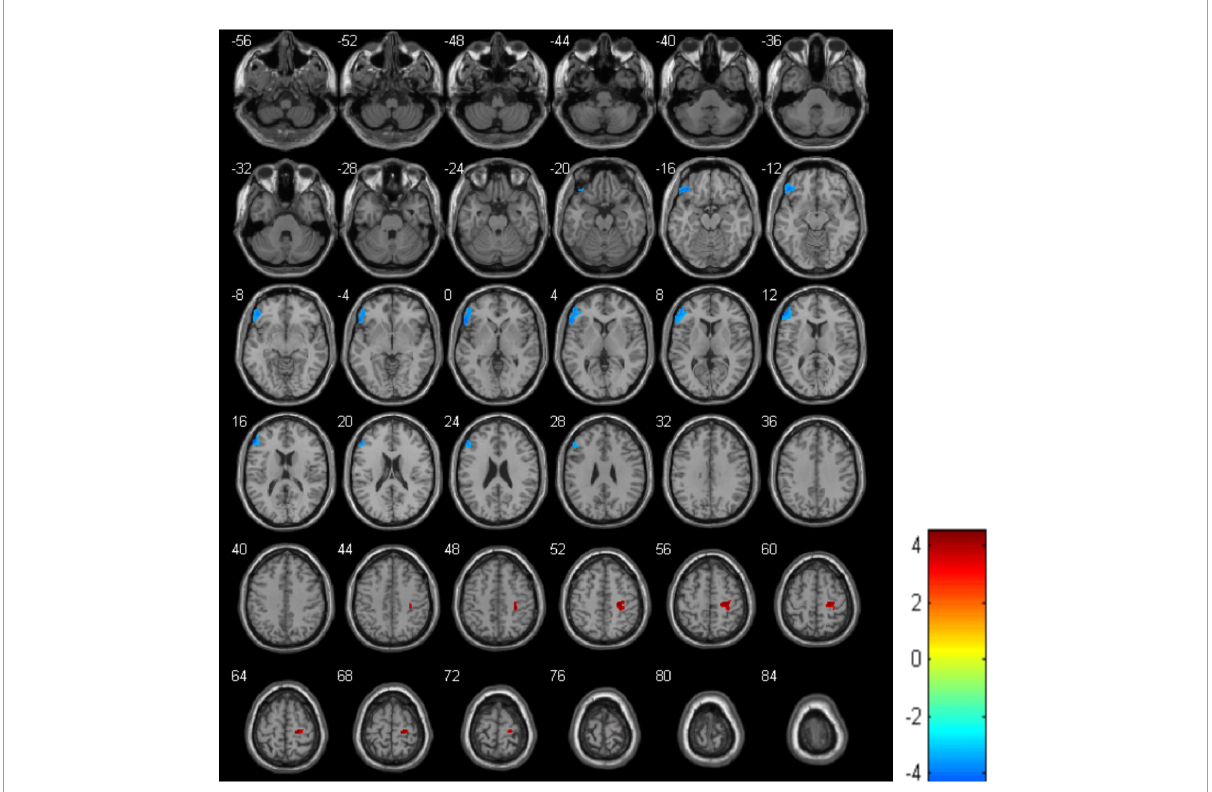
FIGURE1 Differences in regional cerebral blood flow (rCBF) between healthy controls (HCs) and major depressive disorder (MDD) patients. The blue area represents a decrease in rCBF while the red one represents an increase in rCBF.